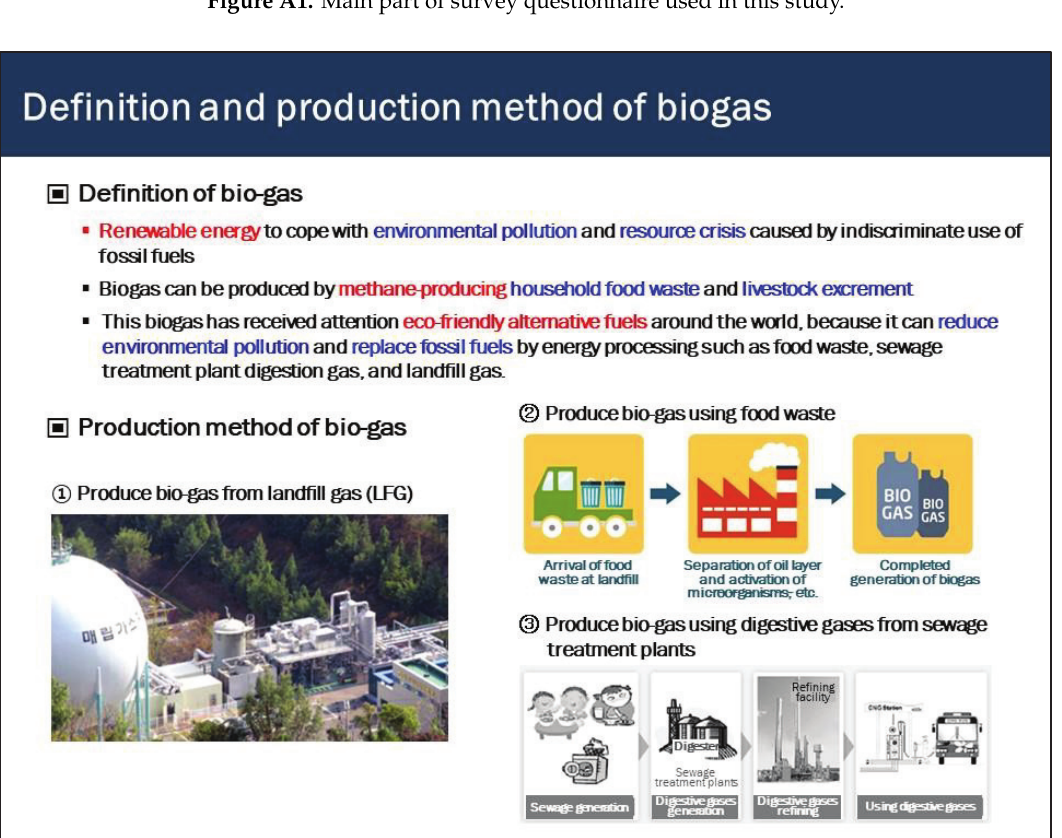
Figure A2. Visual aids used to describe bio-gas to respondents.